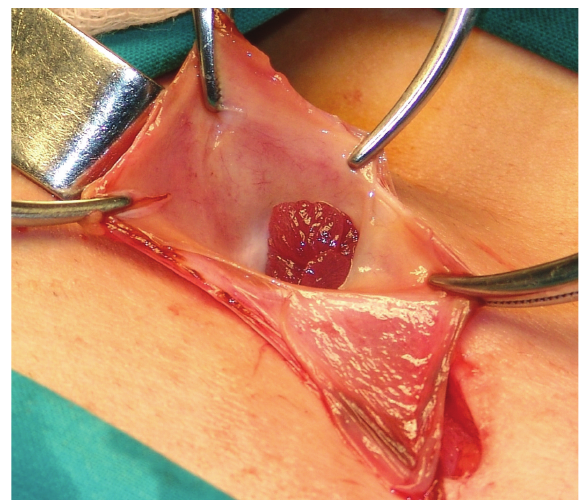
Figure 2: The open femoral hernia sac with its uncommon content, the ipsilateral fallopian tube.